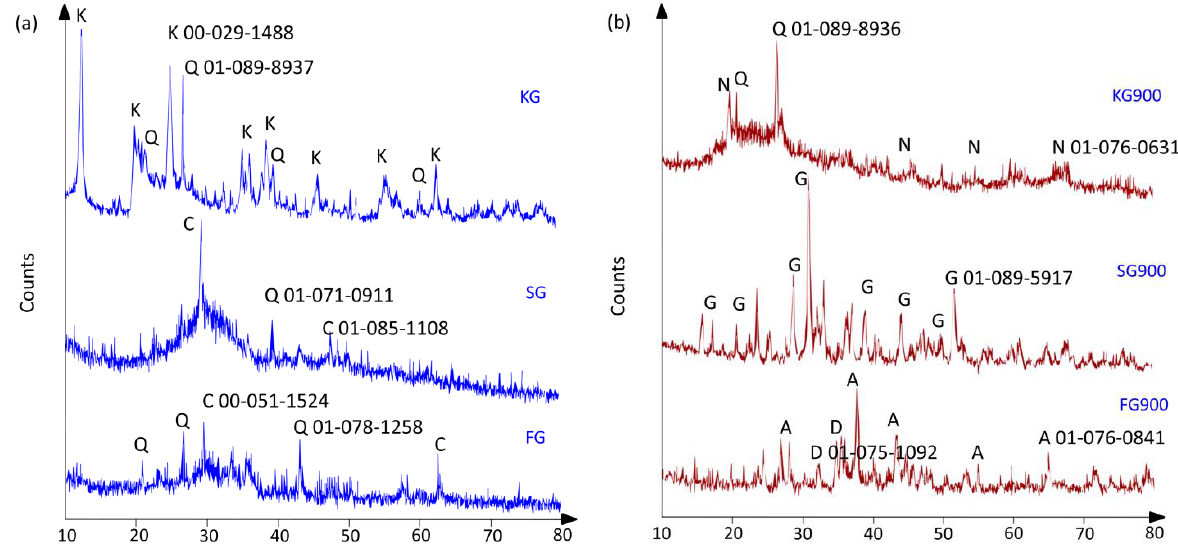
Figure 5. XRD diffractogram of ( a ) the unsintered geopolymer; K—kaolin (PDF No. 00-029-1488), Q—quartz (PDF No. 01-089-8937, 01-071-0911 and 01-078-1258), C—calcite (PDF No. 00-051-1524) and ( b ) the sintered geopolymer, Q—quartz (PDF No. 01-089-08936), N—nepheline (PDF No. 01-076-0631), G—gehlenite (PDF No. 01-089-5917), A—akermanite (PDF No. 01-076-0841), D—diopside (PDF No. 01-075-1092).